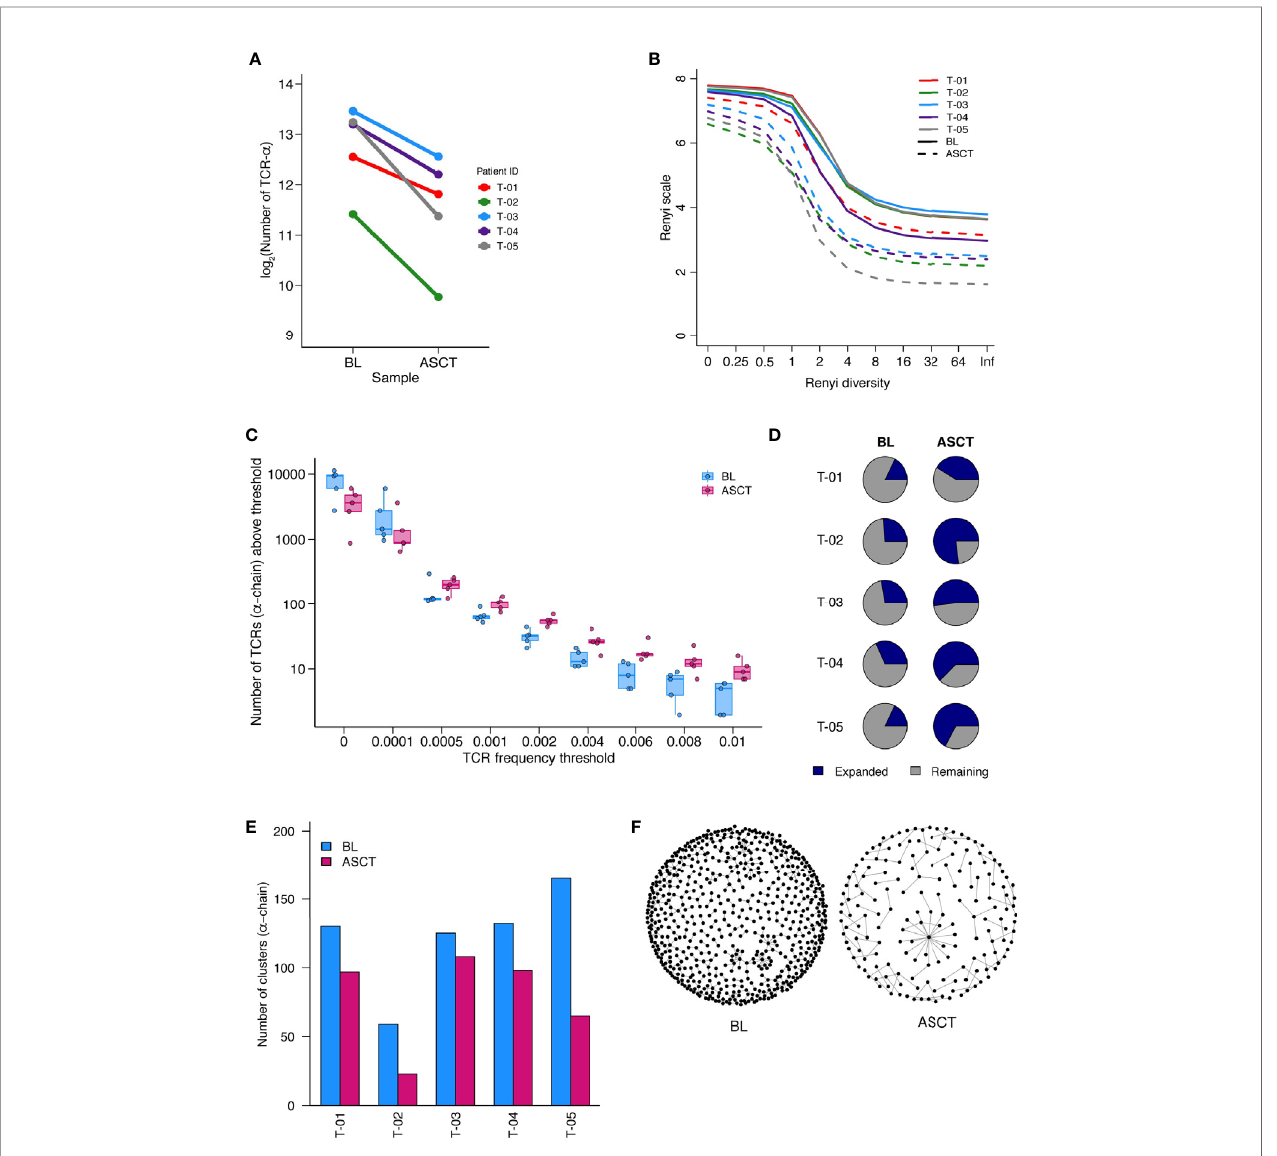
FIGURE 6 | TCR-Sequencing analysis of fi ve paired patient samples at baseline (BL) and post-ASCT. (A) Number of a -chain TCR sequences collected at BL and D100 post-ASCT. Adjusted p=0.0052 by paired t-test. (B) Diversity of repertoires calculated as Renyi entropy values from 0 to in fi nity for the a -chain for each patient sample. Each repertoire was sub-sampled to 3000 TCRs 100 times. (C) Number of a -chain sequences detected above a given frequency threshold. Minimum and maximum values are indicated by extreme points and the thick horizontal line in the middle indicates the median value. (D) Pie-chart for each patient sample depicting the proportion of expanded (frequency >1/1,000) and unexpanded a -chain TCRs. (E) Clustering analysis then performed as a measure of sequence similarity between unique TCRs analysis on the basis of triplet amino acid sharing between two CDR3 sequences. Number of clusters from top 50 expanded a -chain CDR3 sequences per sample. (F) Representative image (T-05) of a -chain CDR3 clustering analysis. (Similarity threshold